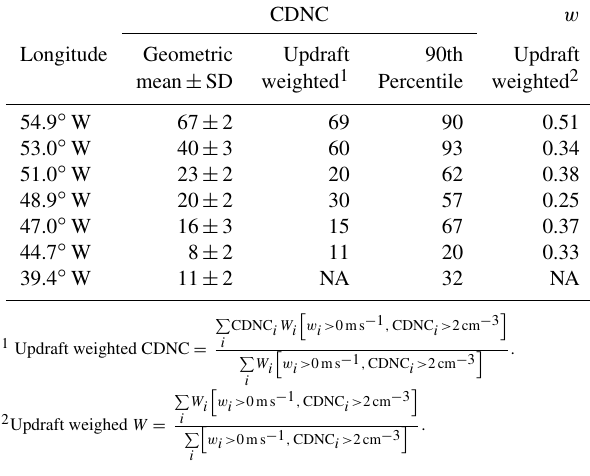
Table 2. In-cloud leg measurements of CDNC (cm − 3 ) and updraft velocity ( w , ms − 1 ) from the C130 flight on 19 September 2017 (Fig. 4). CDNC w Longitude